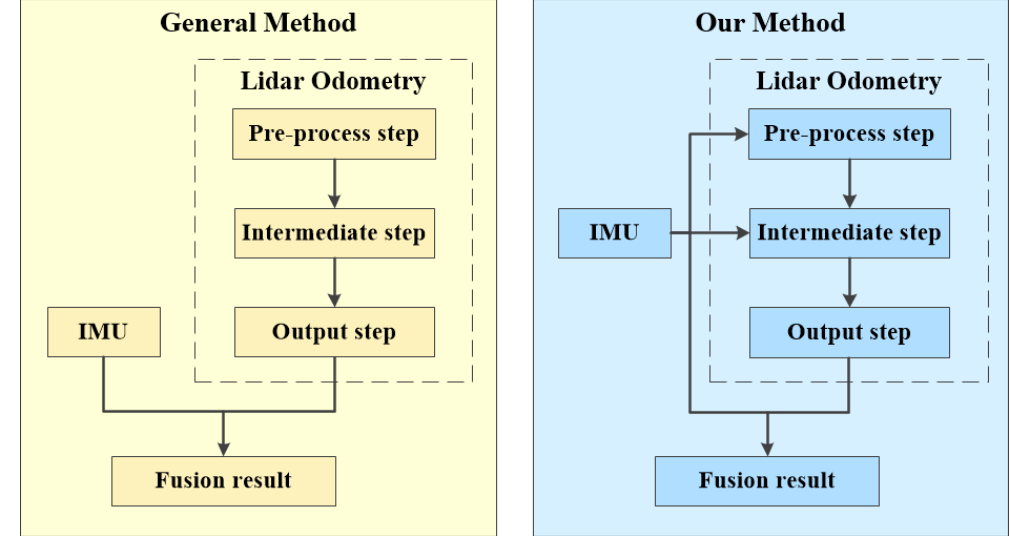
Figure 1. A typical lidar odometry algorithm can be roughly divided into three steps: a pre-processing step, an intermediate step, and an output step. Most existing lidar/Inertial Measurement Unit (IMU) fusion approaches try to fuse lidar odometry and the IMU in the output level [2–7]. In this paper, we try to utilize the IMU information in all the three